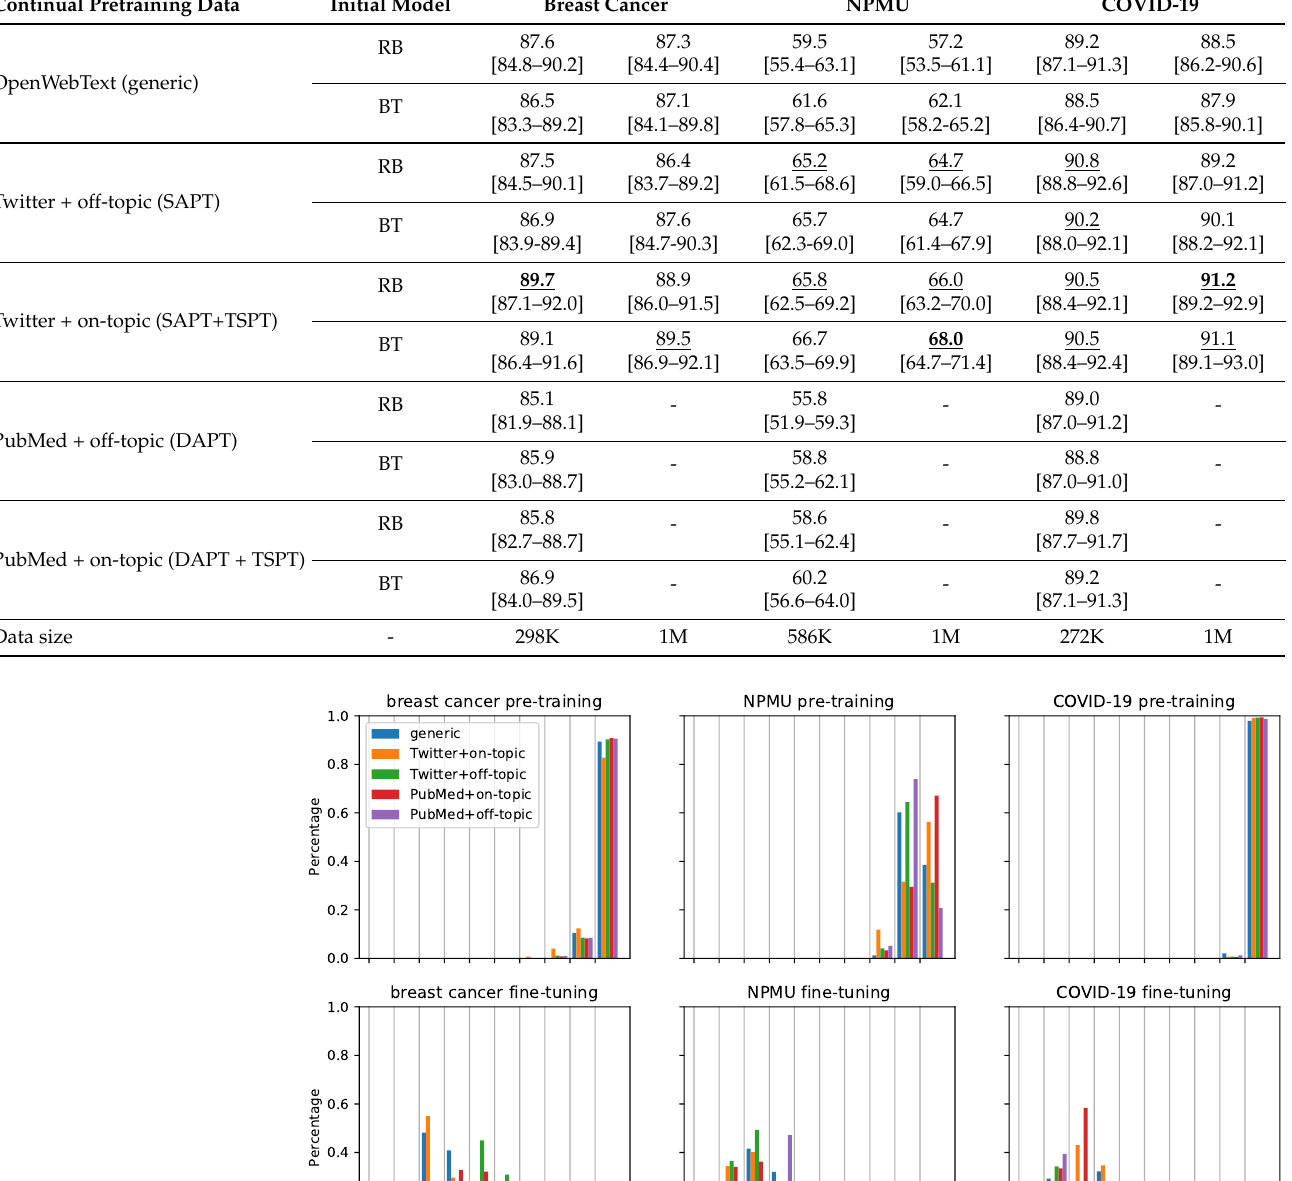
Table 3. Performance metrics obtained by models after pretraining on different data collections. The metric for breast cancer and COVID-19 is the F 1 -score of the positive class, and the metric for NPMU is the F 1 -score for the non-medical use class. RB and BT denote RoBERTa and BERTweet, respectively. Data sizes for extended pretraining are shown at the bottom. The best model for each task is shown in boldface. The models underlined are statistically significantly better than their initial models (i.e., RoBERTa and BERTweet without continual pretraining in Table 2).